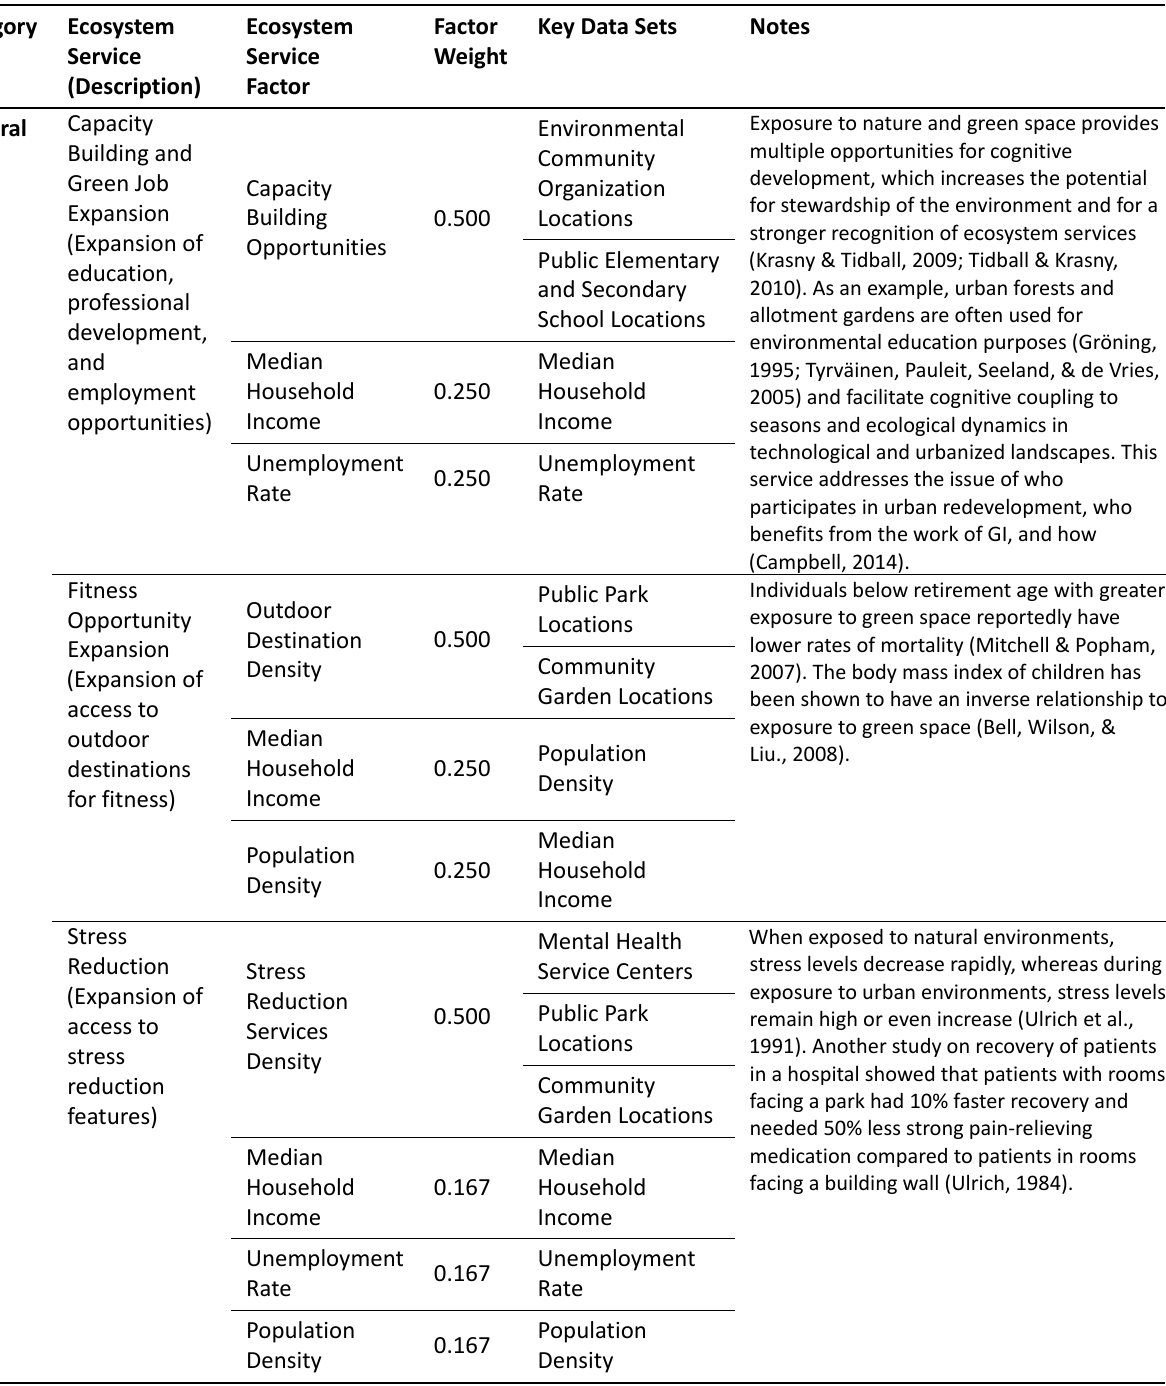
Table 1. Phase one evaluation of ecosystem services.